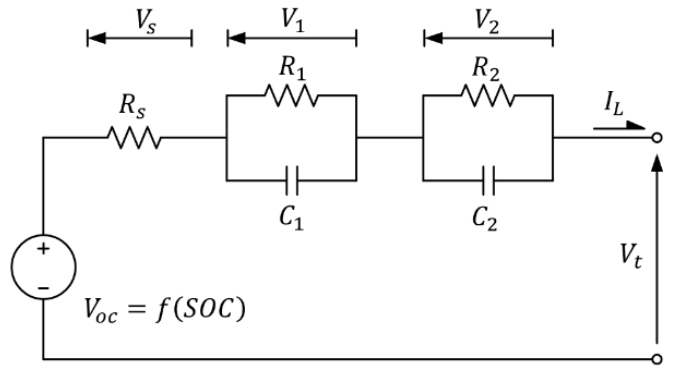
Figure 2. The schematic diagram of the second-order ECM.